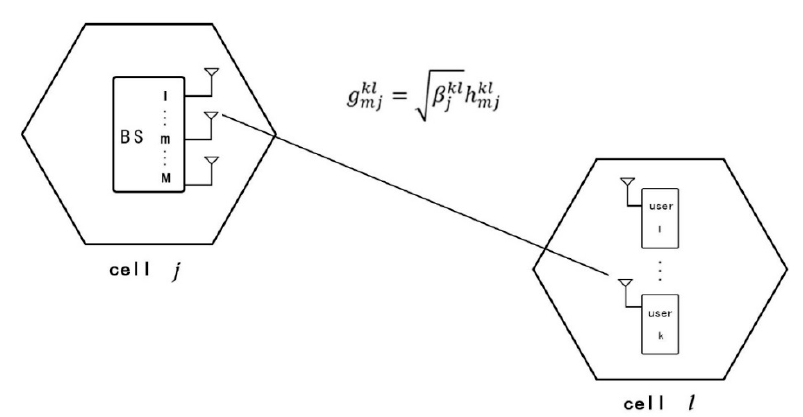
Figure 1. Cell j antenna and cell l user channel Figure 1. Cell (cid:2192) antenna and cell (cid:2194) user channel factors.